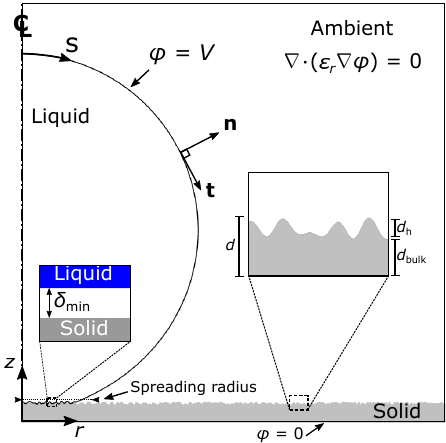
Figure 1. Schematic of the electrospreading setup of an axisymmetric droplet on a structured dielectric substrate (not drawn to